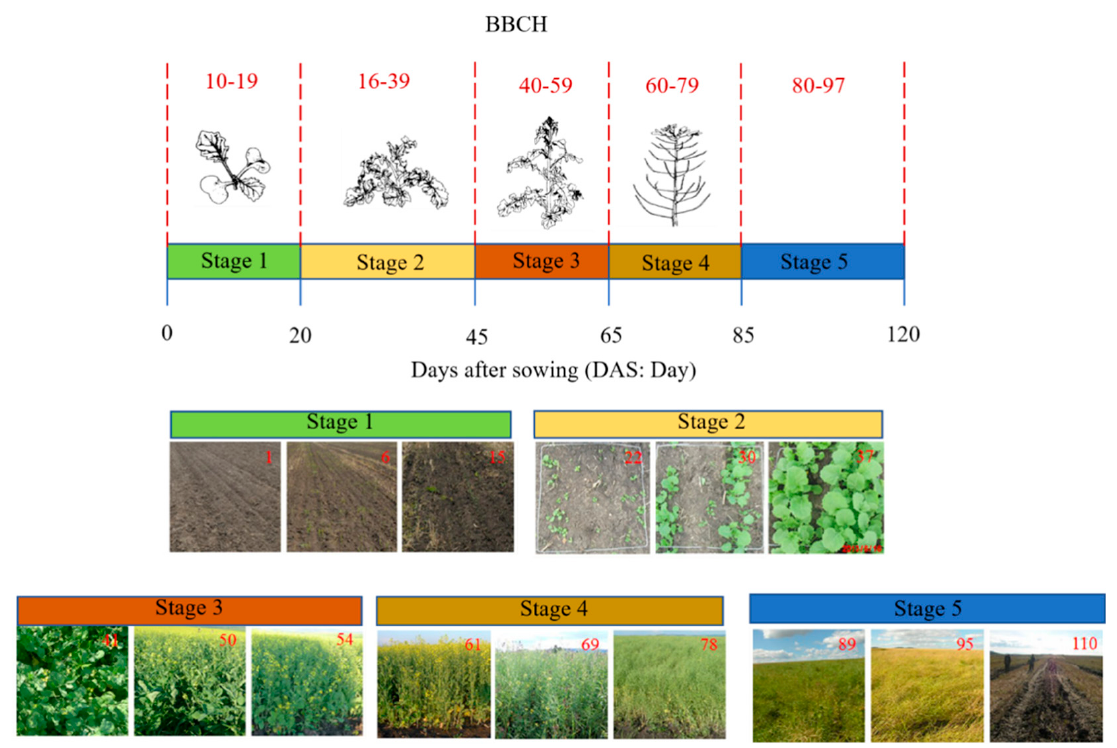
Figure 2. Oilseed rape phenological stages, their corresponding BBCH-codes, DAS, plant images taken from Weber and Bleiholder (1990) and field photos taken during field campaign.